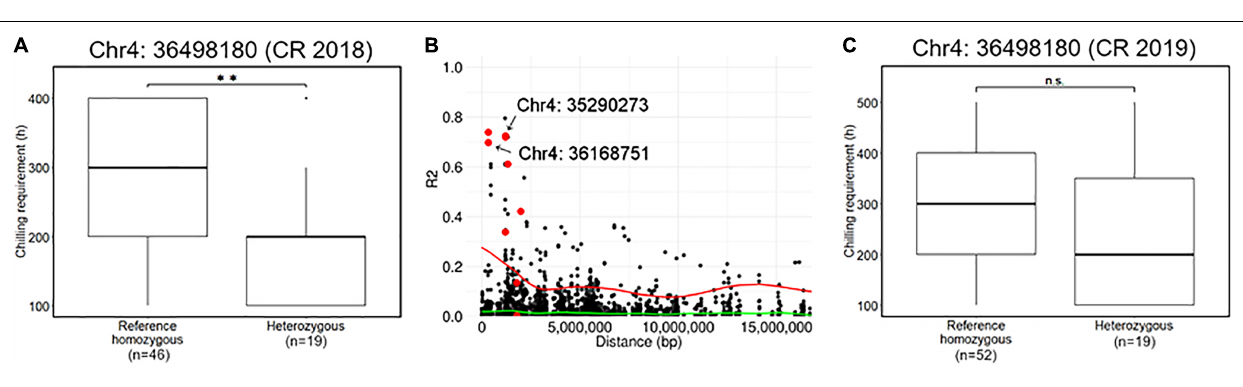
FIGURE 5 | Characterization of a locus significantly associated with the CR. (A) Comparison of CR in 2018–2019 season based on the genotype at the significant locus, Chr4: 36498180. (B) Pairwise allelic genotype correlation plot of Chr4: 36498180 with all other loci on chromosome 4. Red plots represent the other loci significantly associated with CR in the 2018–2019 season detected by GEMMA software (i.e., Figure 4g ). Red and green lines represent a cubic spline fitted for the 95th and 50th percentiles, respectively. (C) Comparison of CR in 2019–2020 season based on the genotype at the significant locus, Chr4: 36498180. Double asterisk ( ∗∗ ) represents the significant difference ( p < 0.01) and n.s. is an abbreviation for